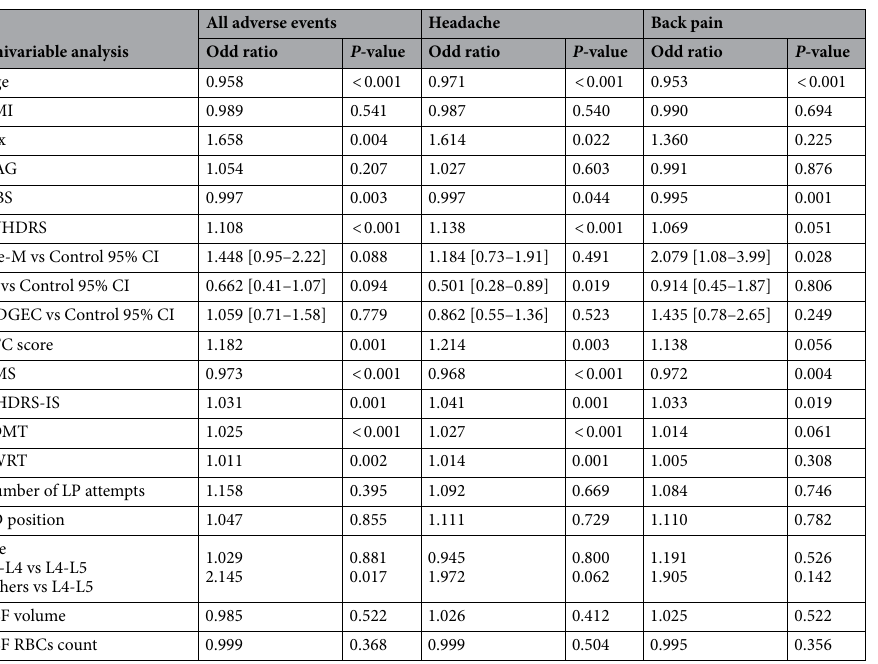
Table 4. Univariable analysis of all adverse events, headache and back pain. BMI body mass index, CAG HTT CAG size, DBS Disease Burden Score, cUHDRS composite Unified Huntington’s Disease Rating Scale, Pre‑M Premanifest HD, M Manifest, HDGEC Huntington’s disease gene expansion carrier, TMS UHDRS Total Motor Score, TFC UHDRS Total Functional Capacity, IS Independence Scale, SWR Stroop Word Reading test, SDMT Symbol Digits Modality Test, LD Lateral Decubitus, RBCs Red Blood